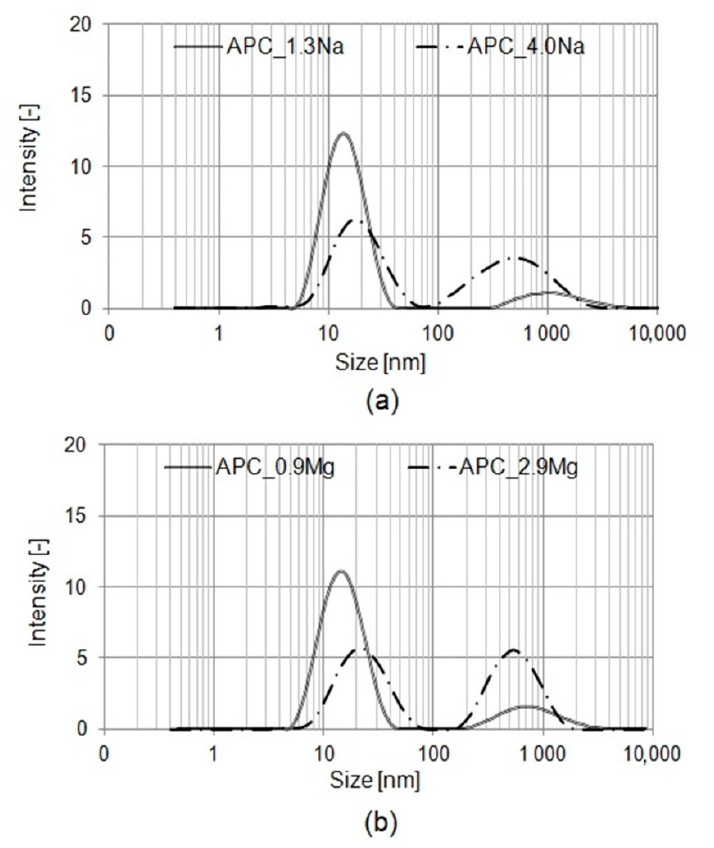
Figure 3. Particle-size distribution of APCs for various salt contents: ( a ) sodium chloride; ( b ) magnesium chloride.